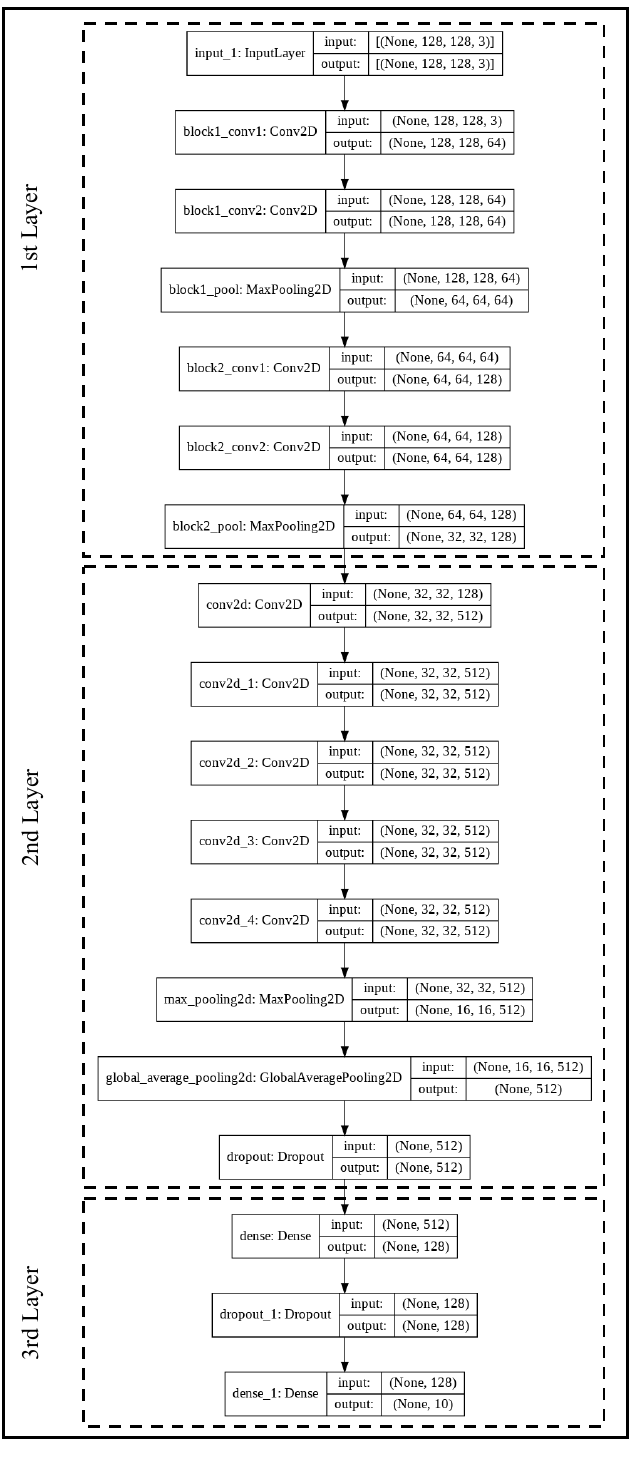
Figure 3. Tuned VGG19